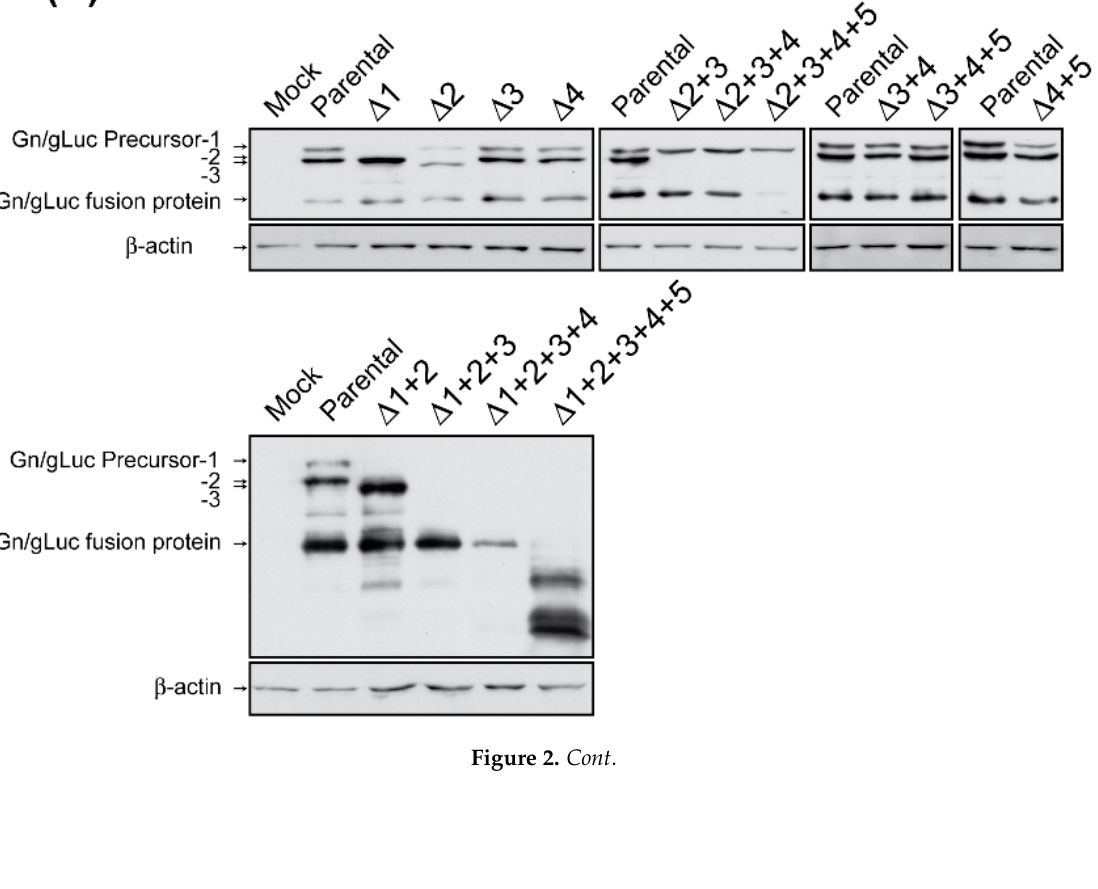
Figure 2. Cont Figure 2. Cont.